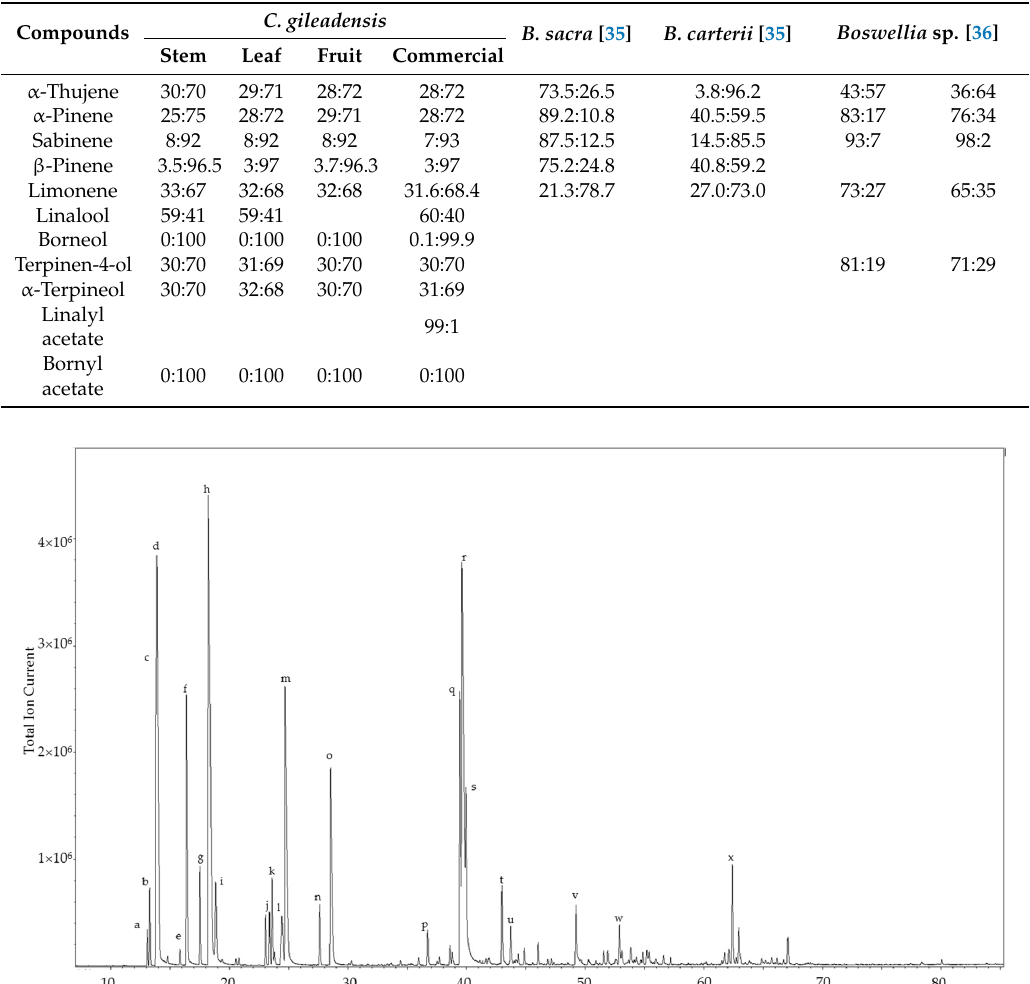
Table 3. Enantiomeric distribution [(+):( − )] of monoterpenoids from Commiphora gileadensis and Boswellia species essential oils.